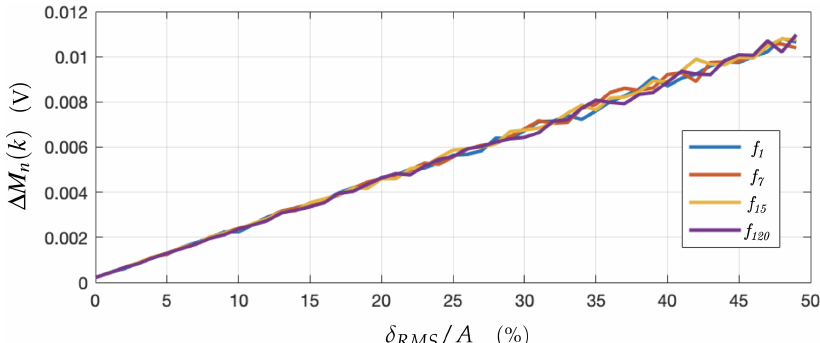
Figure 6. Propagation of the Gaussian white noise through DFT computation for four generated frequencies. The Noise RMS was computed from 1000 Gaussian white noises and averaged out. The four curves follow the same linear interpolation: y = 2.14 × 10 − 4 x + 1.81 × 10 − 4